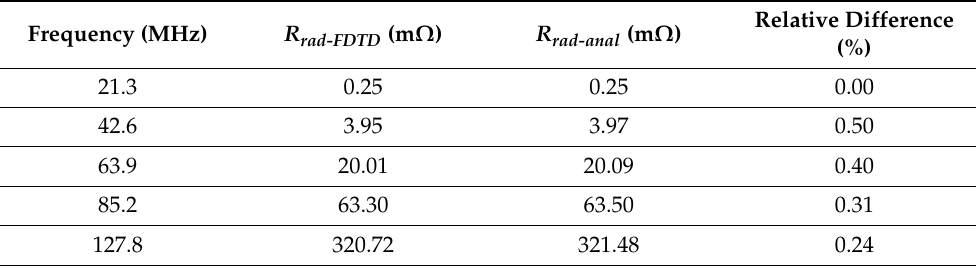
Table 5. Coil radiation resistance estimation for different frequencies ( n = 8-segment loop). FDTD and analytical calculation results.